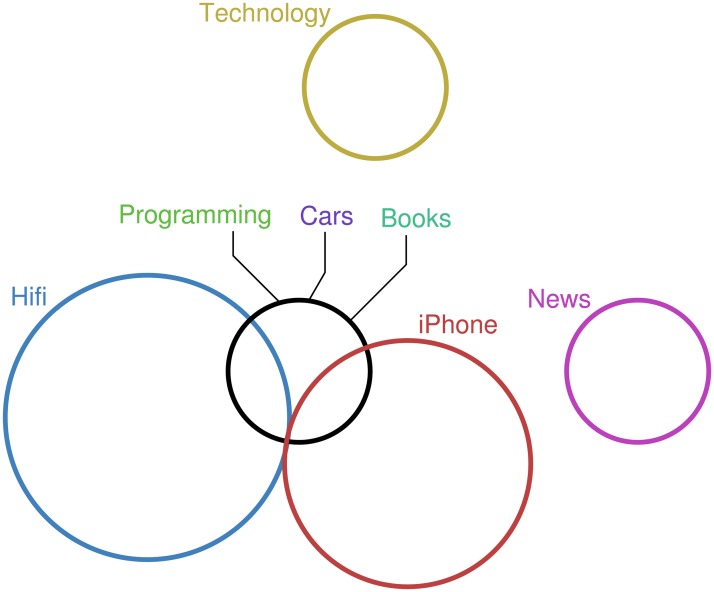
Concurrent curves are depicted in black.